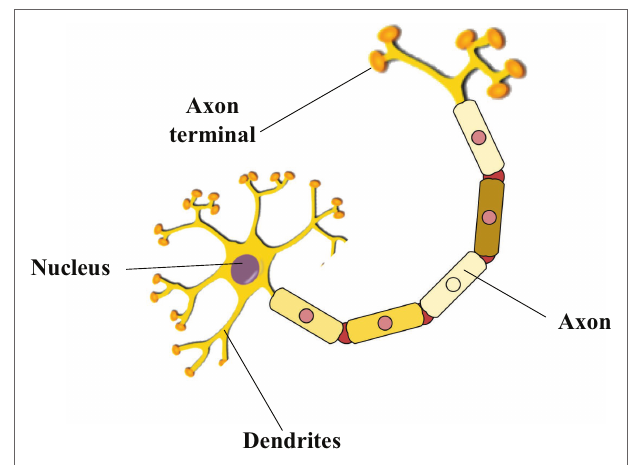
FIGURE 5 | The simple neural reflex structure of the human body.